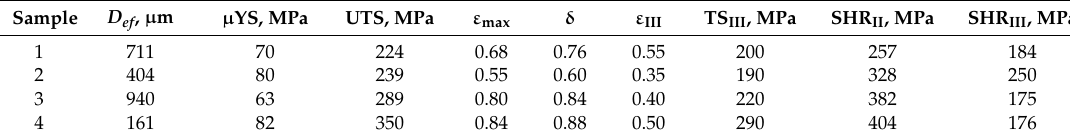
Table 1. Mechanical Tensile Characteristics of the